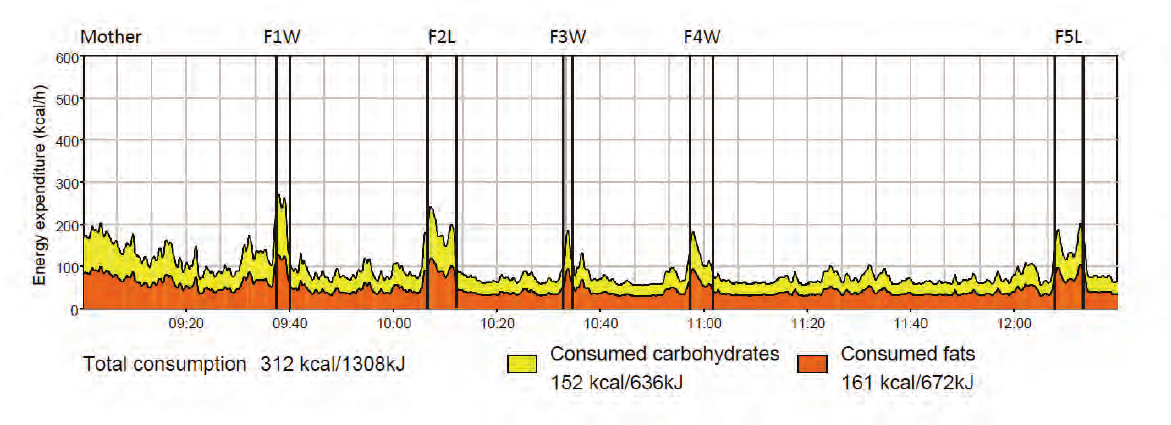
Figure 4. Caloric energy sources and totals of mother immediately before, during, and immediately after watching son